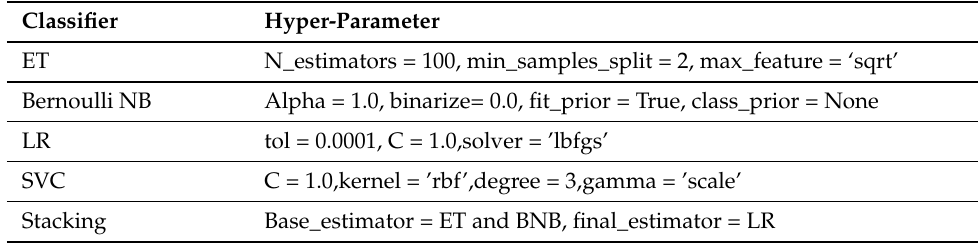
Table 3. Hyper-parameters list for machine learning